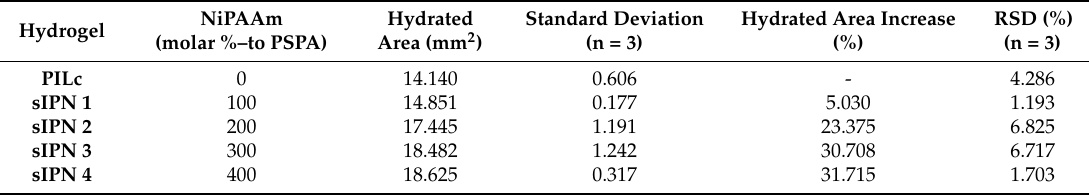
Figure 7. The effect of increasing the mass of linear p(NiPAAm ‐ BSP ‐ AA) copolymer on the fully hydrated hydrogel area (error bars are standard deviations for n = 3 replicate measurements). Table 3. The effect of increasing amount of linear p(NiPAAm ‐ BSP ‐ AA) copolymer on the hydration properties of the hydrogels.